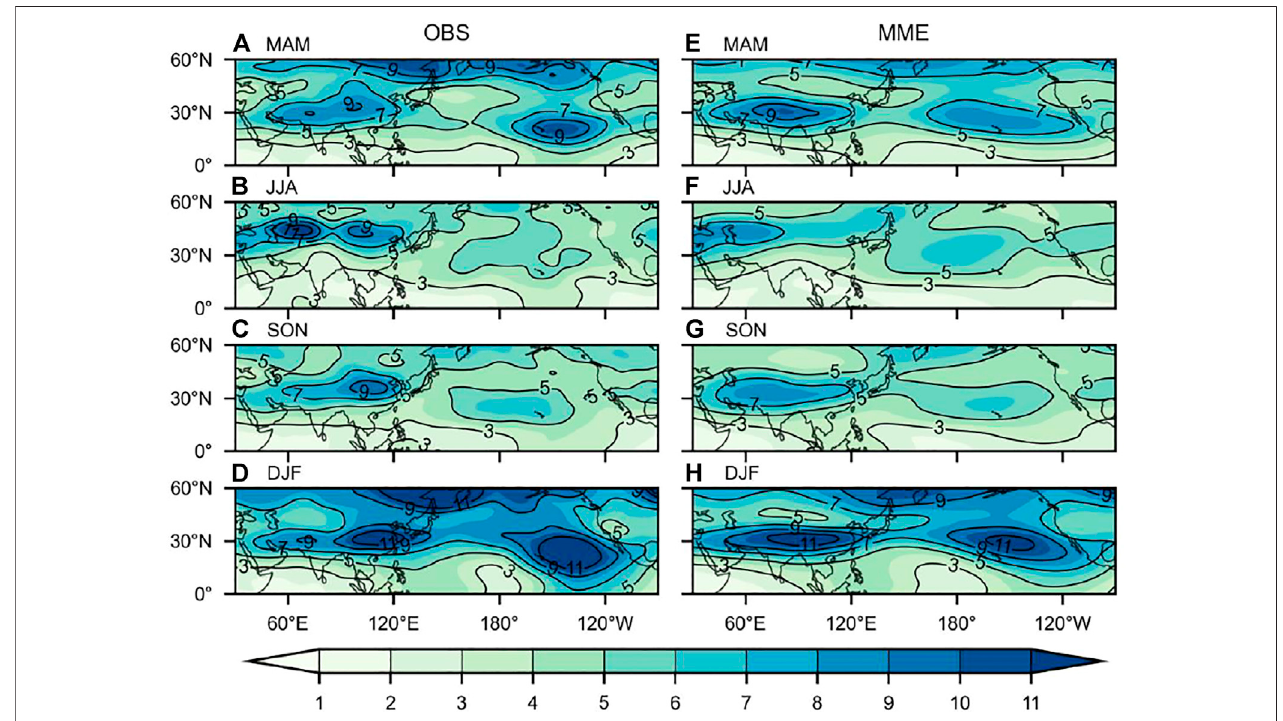
FIGURE 6 | Spatial distribution of standard deviation (unit: 10 – 1 ° C) of (A,E) spring, (B,F) summer, (C,G) autumn and (D,H) winter UTT during 1965 – 2014 from (A – D) NCEP/NCAR reanalysis and (E – H) MME simulation.